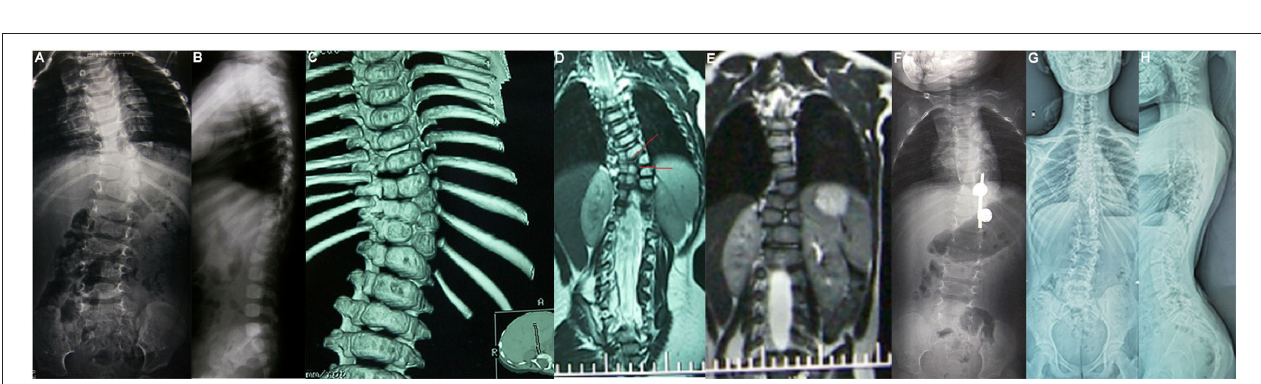
FIGURE 4 | Female aged 1 years 4 months, T9–T10 hemivertebra; T8-12 bone bridge complicated with type II SCM, one-stage posterior T9–10 hemivertebra Schwab grade 5 osteotomy, T9-10 nail hook internal fixation, preoperative x-ray (A,B) , preoperative CT (C,D) , postoperative CT (E) , postoperative x-ray (F) 1 year after operation, and the X-ray display was further improved 12 years after the last follow-up (G,H)